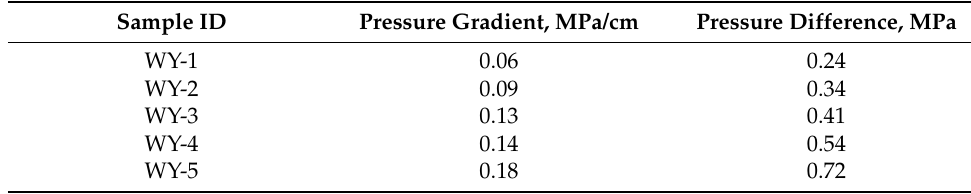
Figure 2. Schematic diagram of experimental device. Table 3. Corresponding table between shale sample and backflow pressure difference.